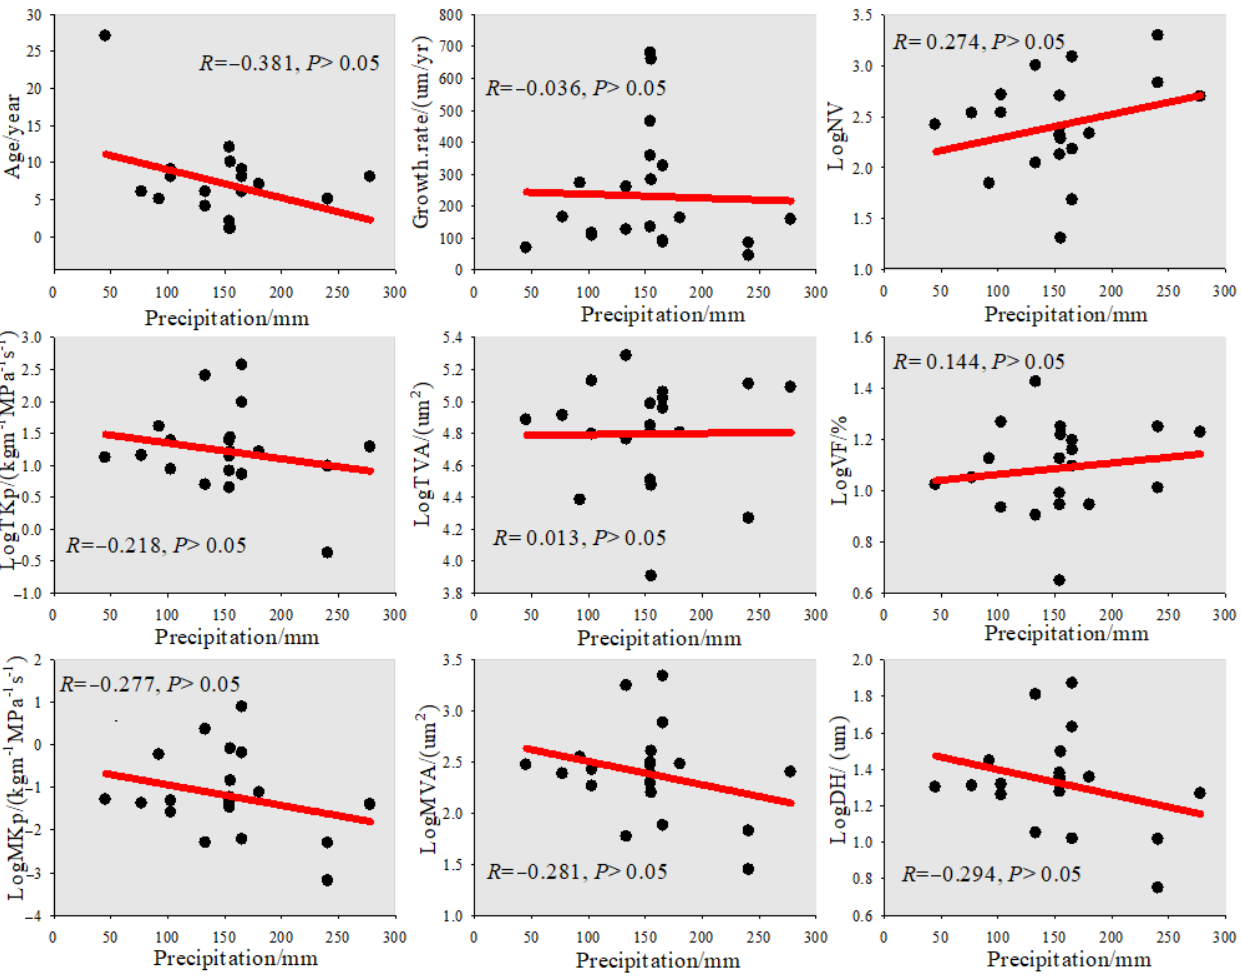
Figure 6. The anatomical characteristics of the root vessels of Zygophyllaceae plants in China’s arid and semi-arid regions change with precipitation gradient. Age: (year); Growth.rate: (μm/year); NV: vessel number; VF: vessel fraction (%); TAV: total vessel area ( μm² ); MVA: mean vessel area ( μm² ); TKp: total water transfer efficiency (kg m −1 MPa −1 s −1 ); MKp: mean water transfer efficiency (kg m −1